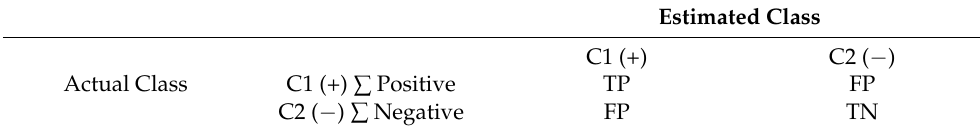
Table 3. A confusion matrix for a two-class